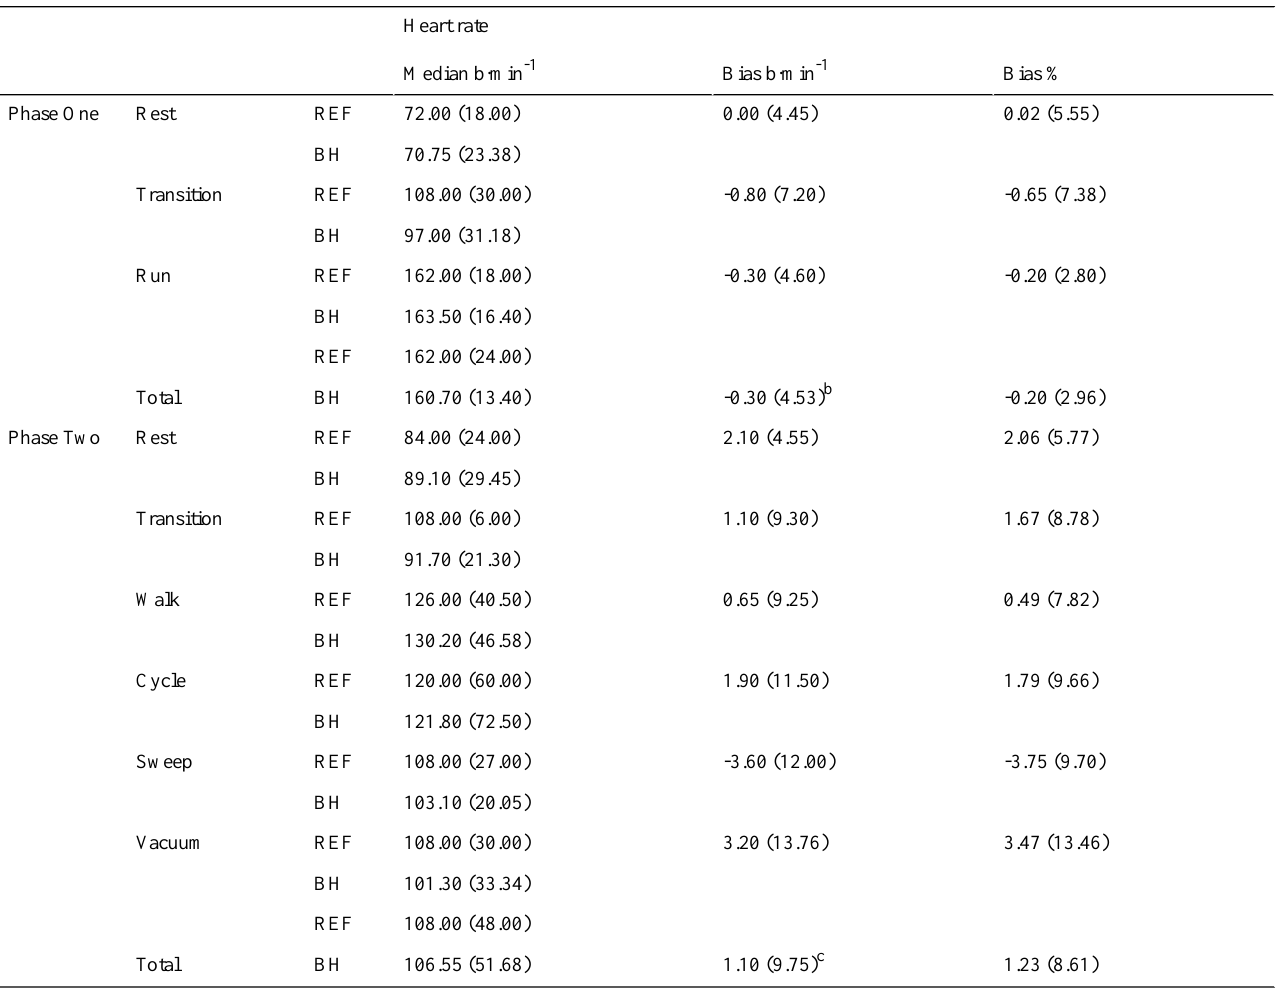
Table 2. Biases between BioHarness and reference heart rate (Phase One: participants in sinus rhythm; Phase Two participants with atrial fibrillation) a .